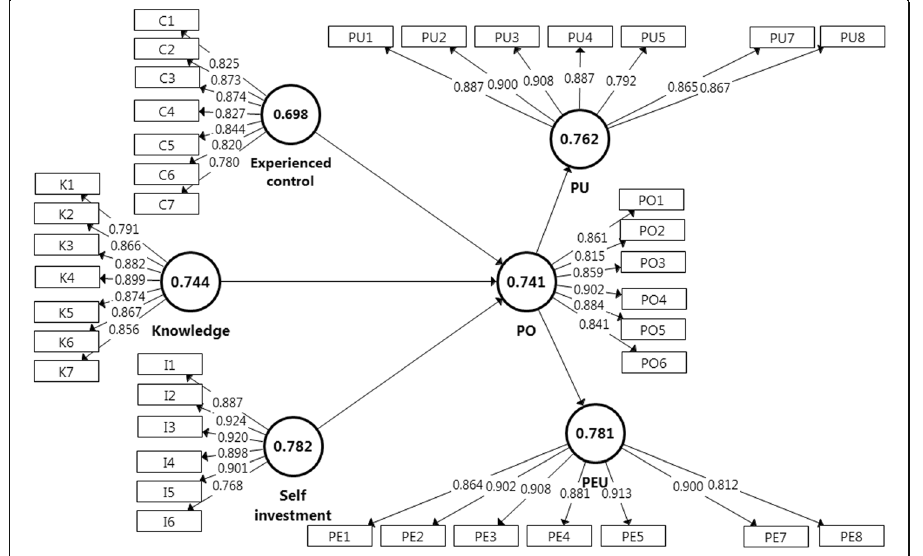
Fig. 4 Measurement model with item loadings and